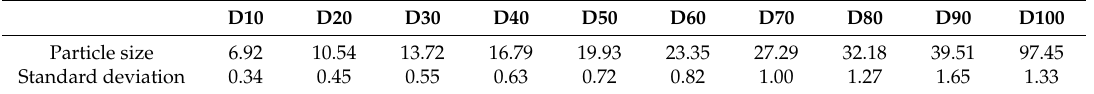
Figure 3. Differential distribution and cumulative distribution of sediments. Table 1. Size distribution of sediment particles.